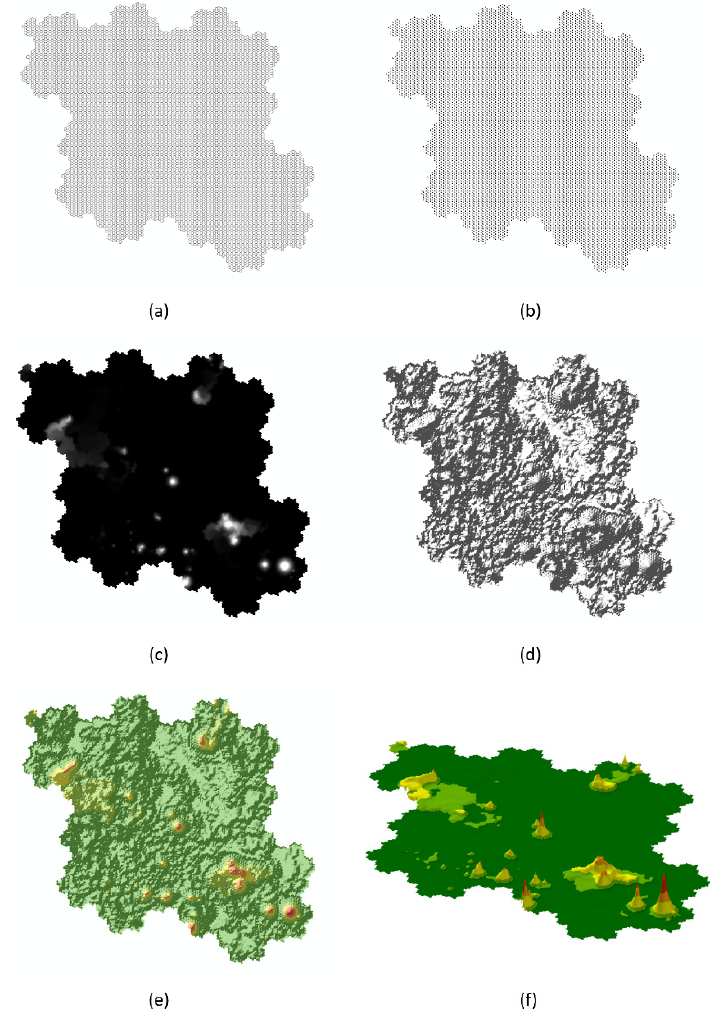
Figure 9. The construction process of the virtual terrain of ArcGIS Desktop 10.1: ( a ) bottom hexagons corresponding to files; ( b ) geometric center points of the bottom hexagons; ( c ) grid field model result of files; ( d ) mountain shadow layer generated by the grid data; ( e ) two-dimensional virtual terrain; ( f ) three-dimensional virtual terrain.